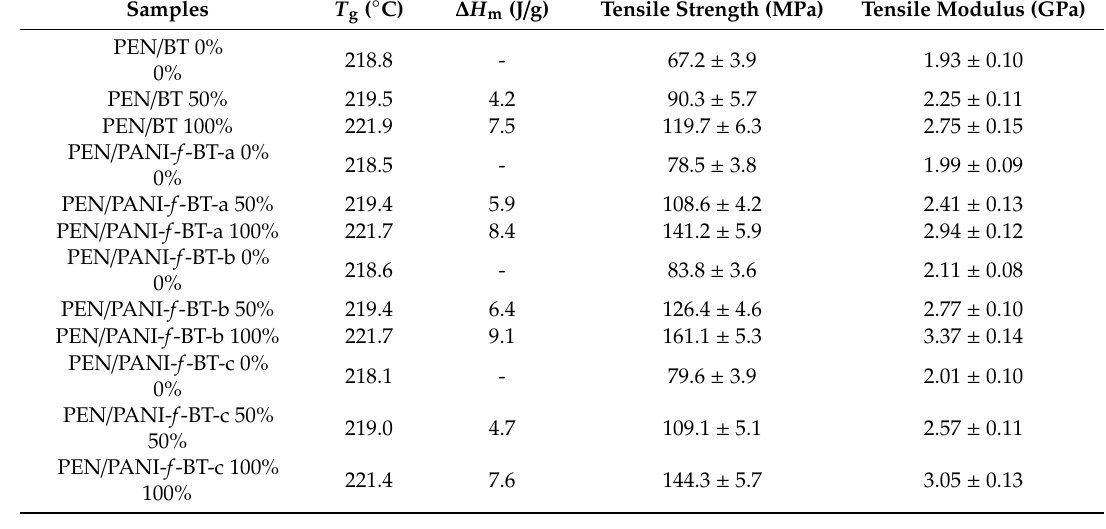
Table 1. Thermal and mechanical properties of nanocomposites at di ff erent stretching ratios.